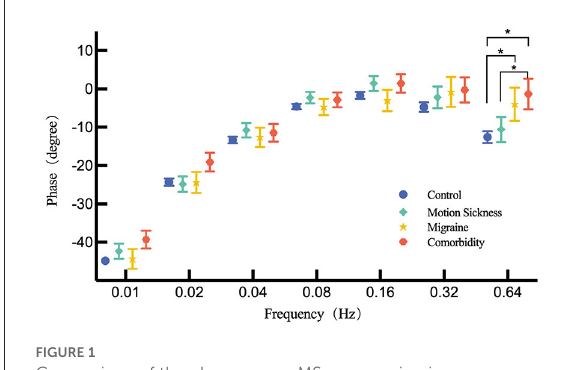
FIGURE1 Comparison of the phase across MS group, migraine group, comorbidity group and control group for each frequency by multiple-factors ANOVA. Corrected phase values are presented by mean and standard error. The asterisk (*) indicates a significant difference